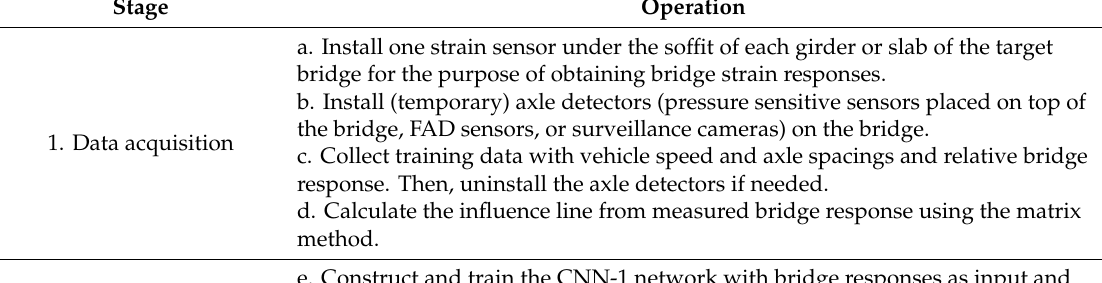
Table A1. Suggested implementation procedure of BwimNet in real application.